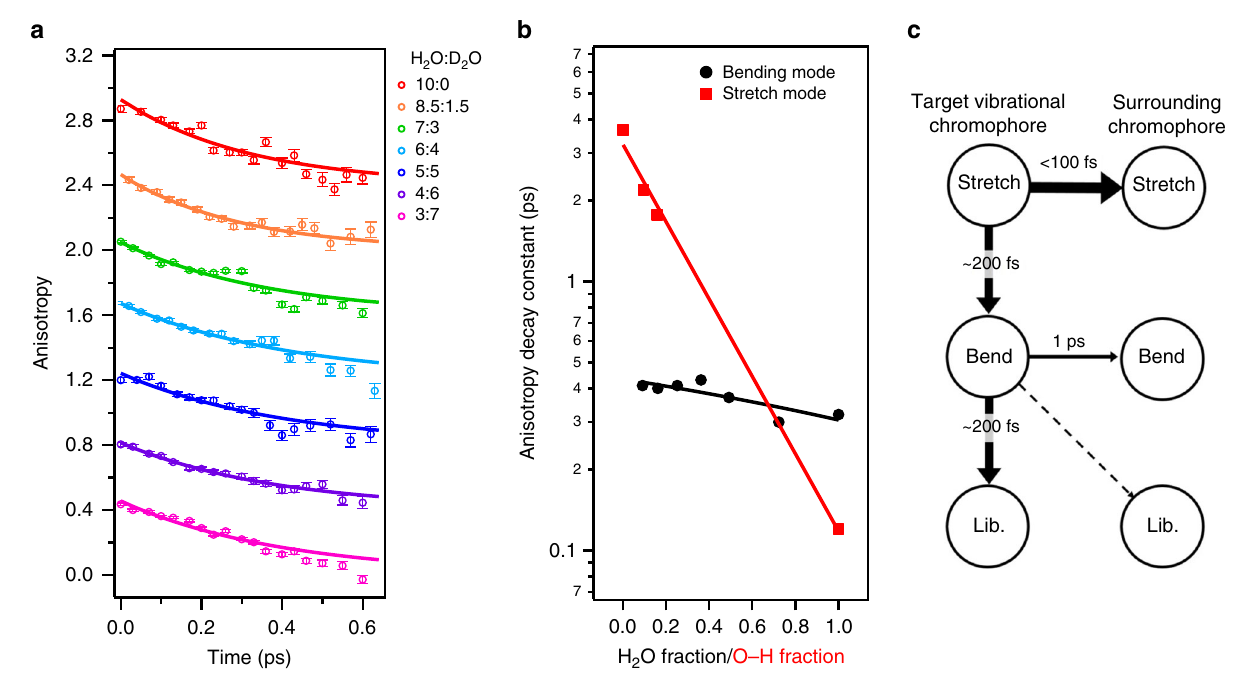
Fig. 4 The anisotropy decay of various isotopic composition and schematic for the vibrational energy relaxation of water molecules. a Anisotropy decay for various H 2 O-D 2 O mixtures. To obtain the excitation anisotropy, the signals arising from the hot ground state were subtracted from the raw data. Traces are offset by increments of 0.4. Symbols show experimental data and solid lines show fi ts using a single exponential decay. b Comparison of the anisotropy decay time for the bending mode and the stretch mode as a function of H 2 O/O – H fraction. The H 2 O/O – H fraction represent the mole fraction of H 2 O molecules and of O – H stretch groups for various H 2 O-D 2 O mixtures, respectively. The stretch mode decay times were obtained by fi tting an exponential decay to the data reported in ref. 7 . The lines serve to guide the eye. c Schematic representation for the vibrational energy relaxation of H – O – H molecules in neat water. The stretch mode timescales were taken from refs. 15,27,51,52 . The target vibrational chromophore is the initial excited H – O – H molecule. The surrounding chromophores are the water molecules surrounding the excited